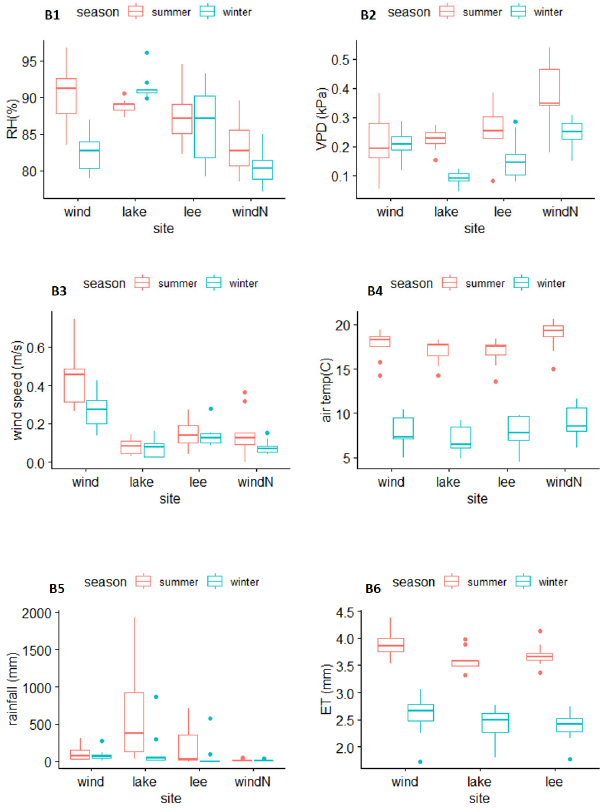
Figure A1. Three month mean and standard deviation of canopy microclimate at four sites in 2019 summer and 2019–2020 winter. B1: RH, relative humidity, B2: VPD, vapor pressure deficit, B3: windspeed, B4: air temperature, B5: rainfall, B6: ET, evapotranspiration.